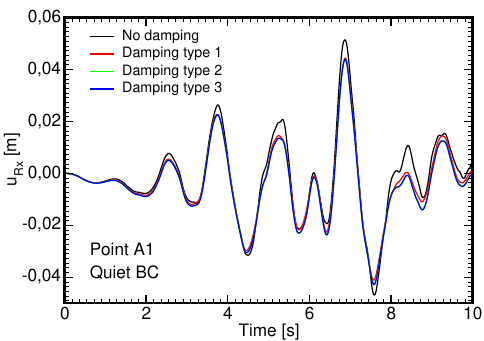
Figure 8. Influence of the type damping - QBB